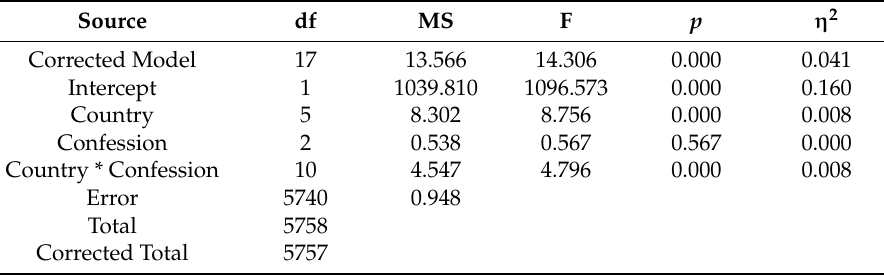
Table A15. Country and confession on evading taxes.